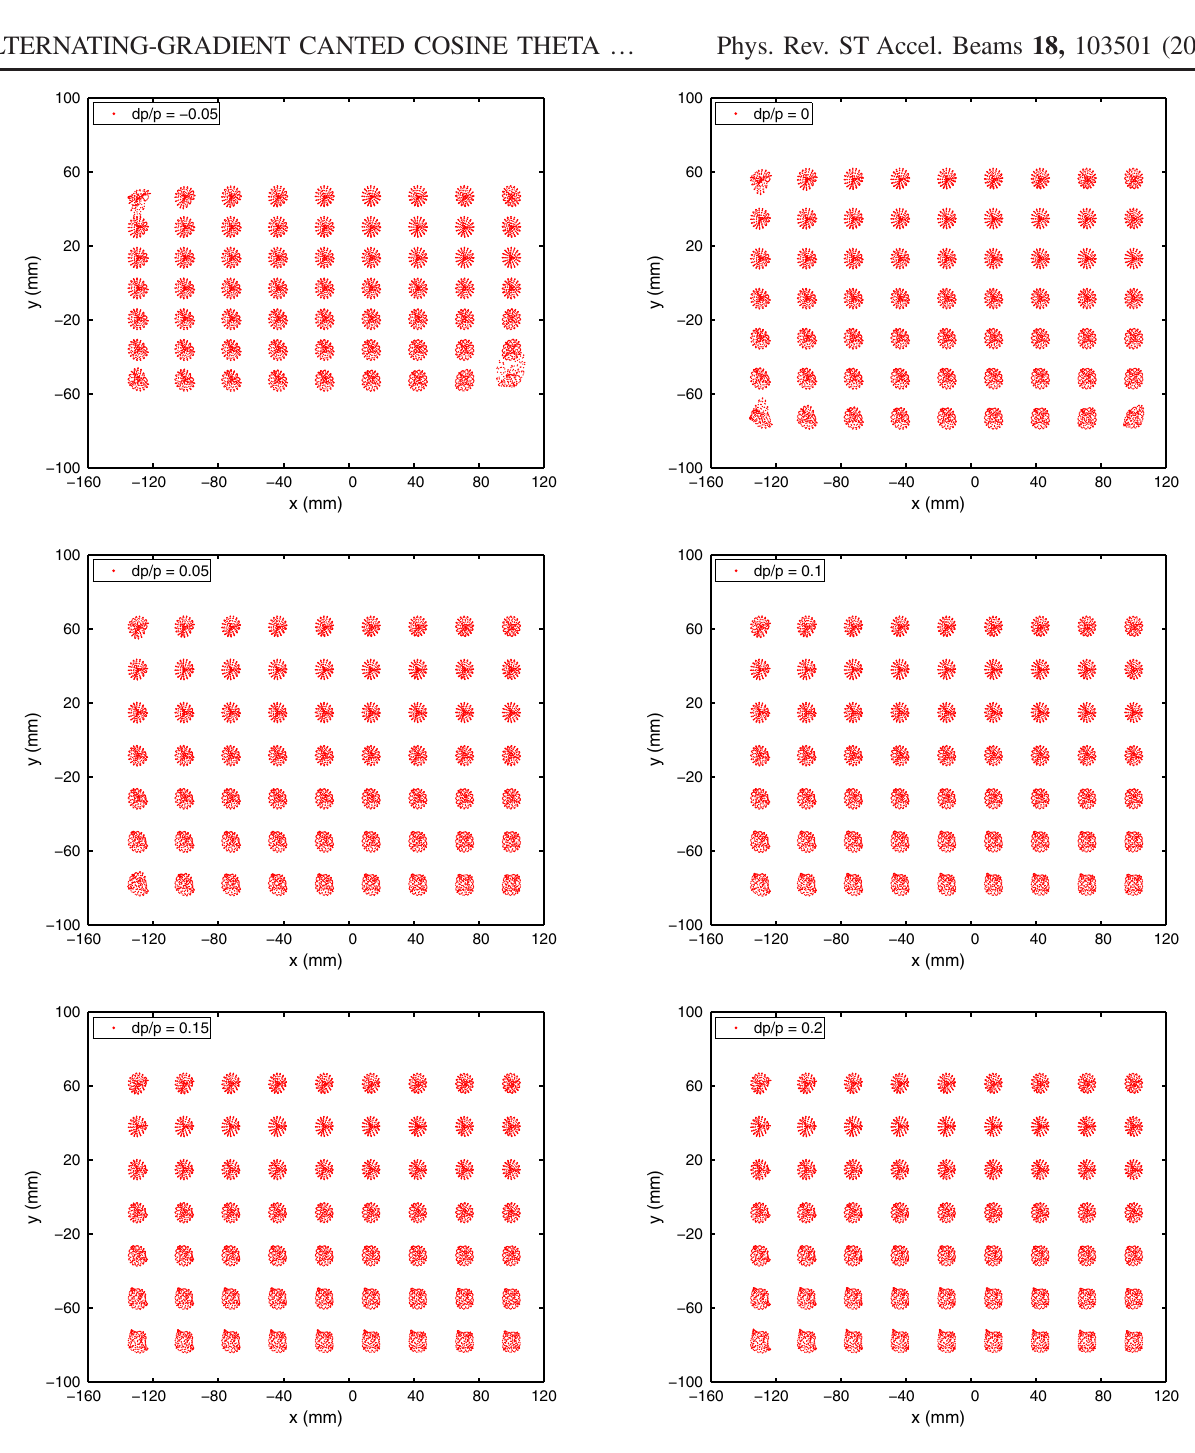
FIG. 21. Grid scans with full correction for Δ p=p ¼ − 5% , 0%, +5%, +10%, +15%, +20%. Note the rectangular grid size of 23 cm × 10 cm for Δ p=p ¼ − 5% and 23 cm × 14 cm for Δ p=p ≥ 0%